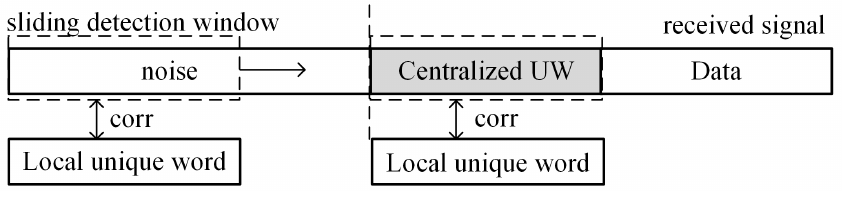
Figure 4. TDC detection